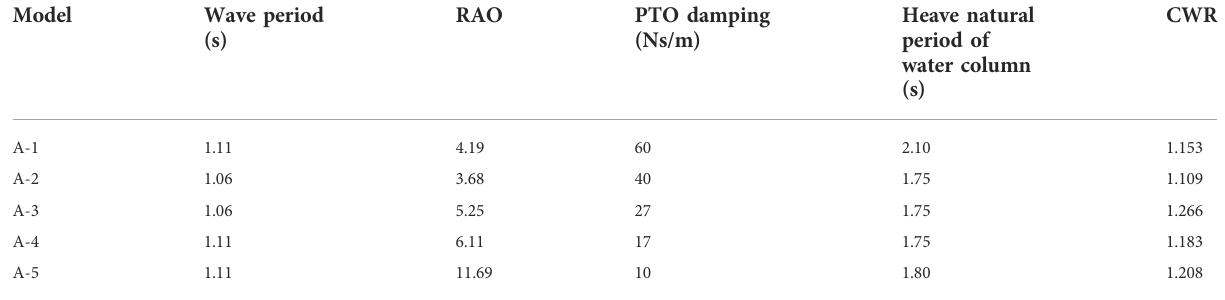
TABLE 2 Peak capture performance of fi ve dual-chamber OWC models.